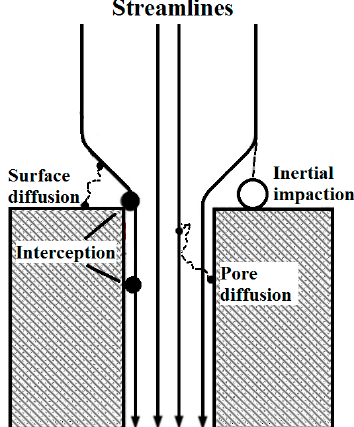
Figure 3. Schematic filtration mechanisms involved in separation on a CPM.